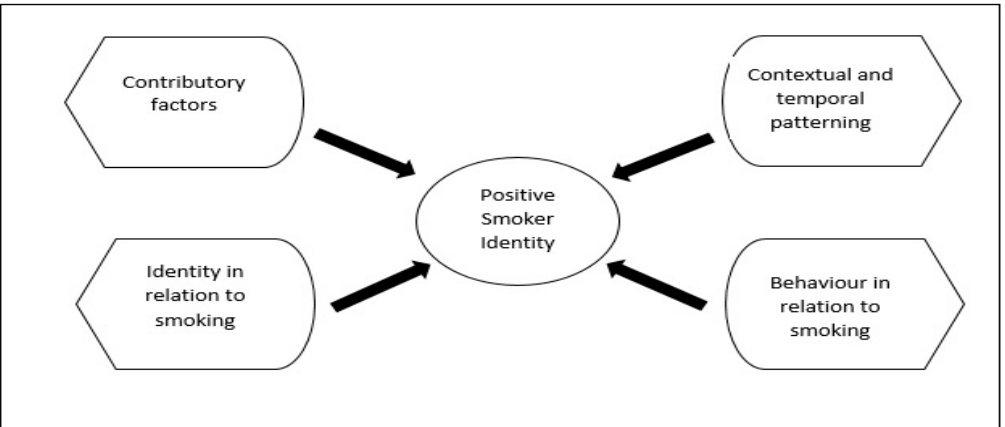
Figure 2. Four domains under the positive smoker identity construct. First factor: Contributory factors that lead to cigarette smoking. Second factor: Contextual and temporal patterning, which reflects the dynamic characteristic of smoking behaviour. Third factor: Identity in relation to smoking, which identifies self-categorization of a smoker. Fourth factor: Behaviour in relation to smoking.